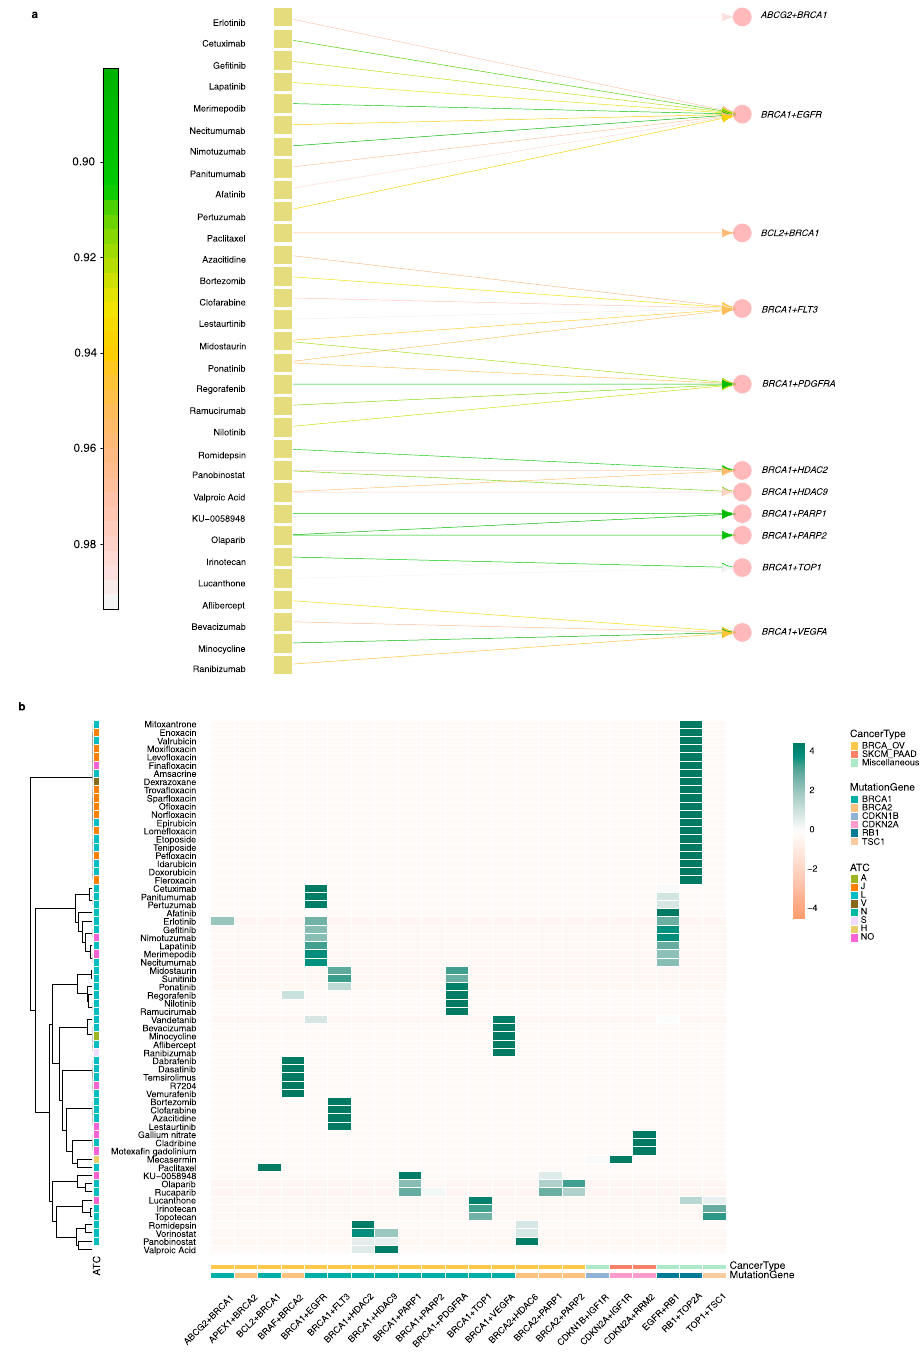
Fig. 5 Example of drug combinations and the visualization of the drug combinations. a Bipartite graph between drug (yellow square) and SL pairs (pink circle). Side annotation bar represents DrugScore. b Heat map visualization between drugs and cancer types of repurposed cancers. Side annotation bar represents the drug repositioning scores of each